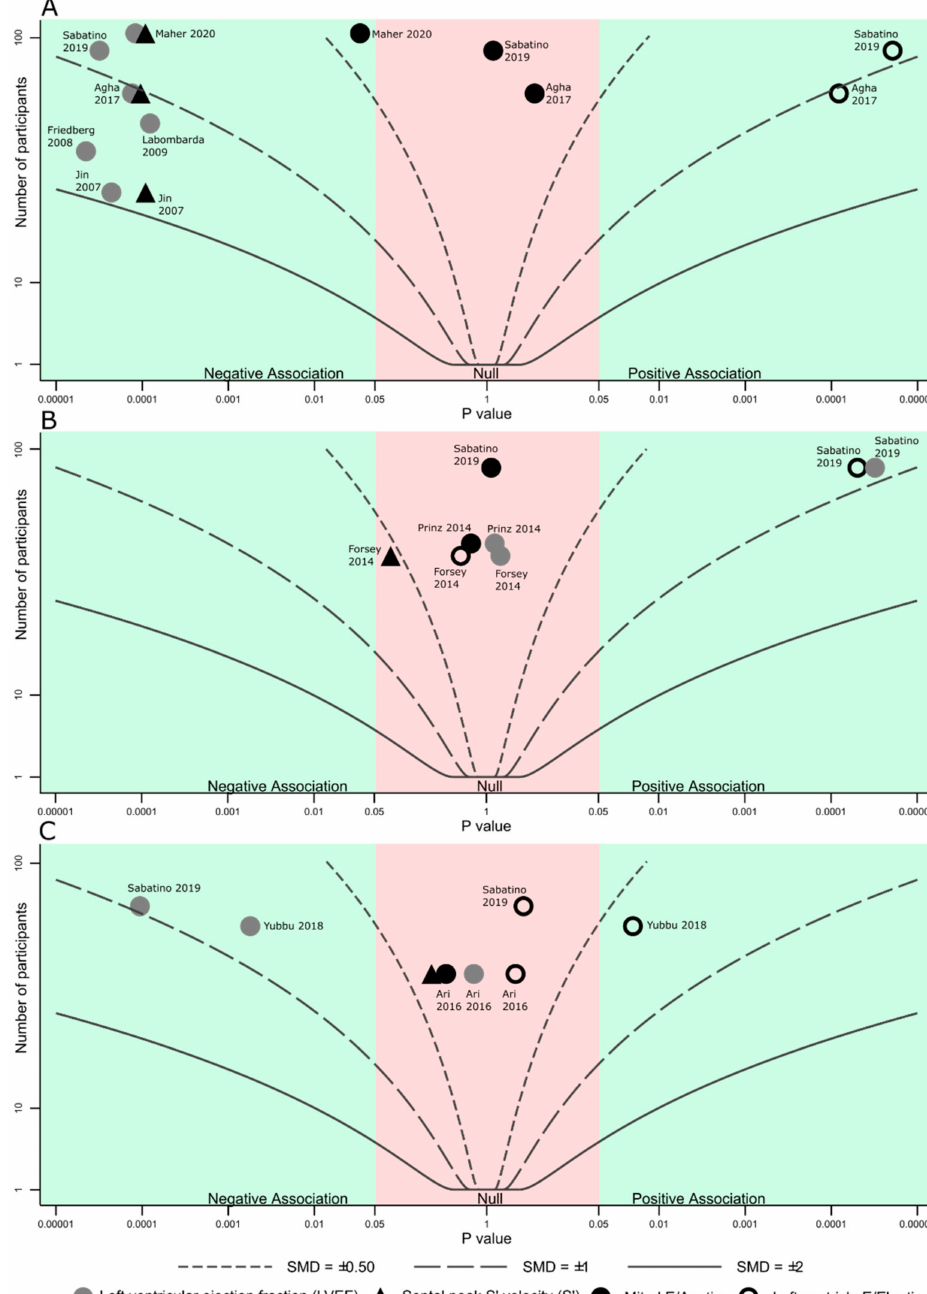
Figure 3. Albatross plot showing estimated standardized mean differences contours (curved lines), p values for difference between inherited cardiomyopathies and controls (horizontal axis) and study sample size (vertical axis) of conventional echocardiographic measurements by cardiomyopathy type in ( A ). Dilated cardiomyopathy; ( B ). Hypertrophic cardiomy- opathy ( C ). Left ventricular non-compaction. Negative association–lower values (including more negative) associated with disease; positive association–higher values (including less negative) associated with